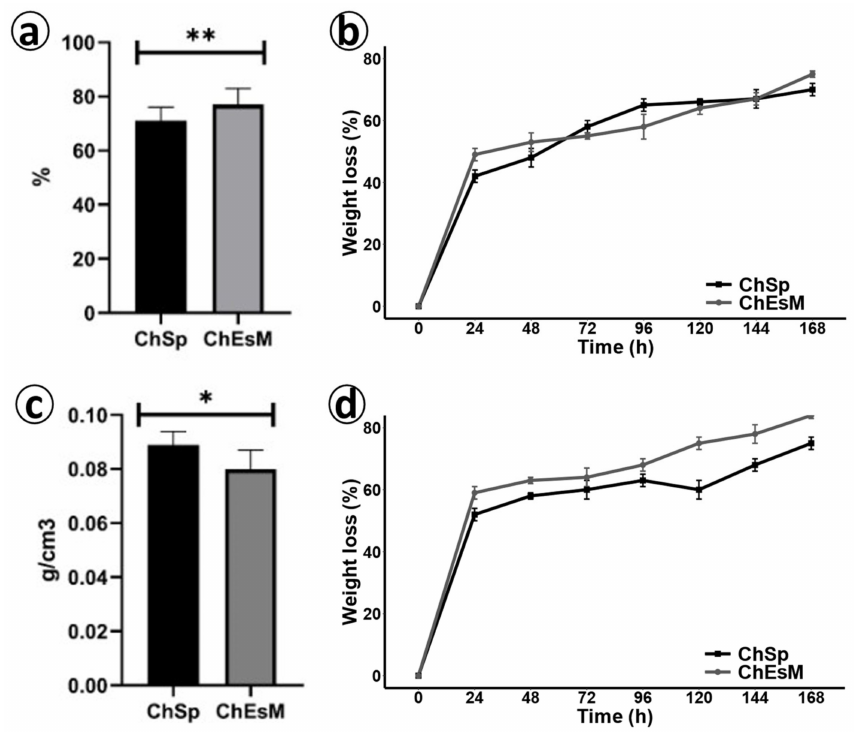
Figure 3. The porosity ( a ), density ( c ), degradation in SBF( b ) and biodegradation in lysozyme solution ( d ) of hemostatic materials; * ( p ≤ 0.05) and ** ( p ≤ 0.001)—the significant between two